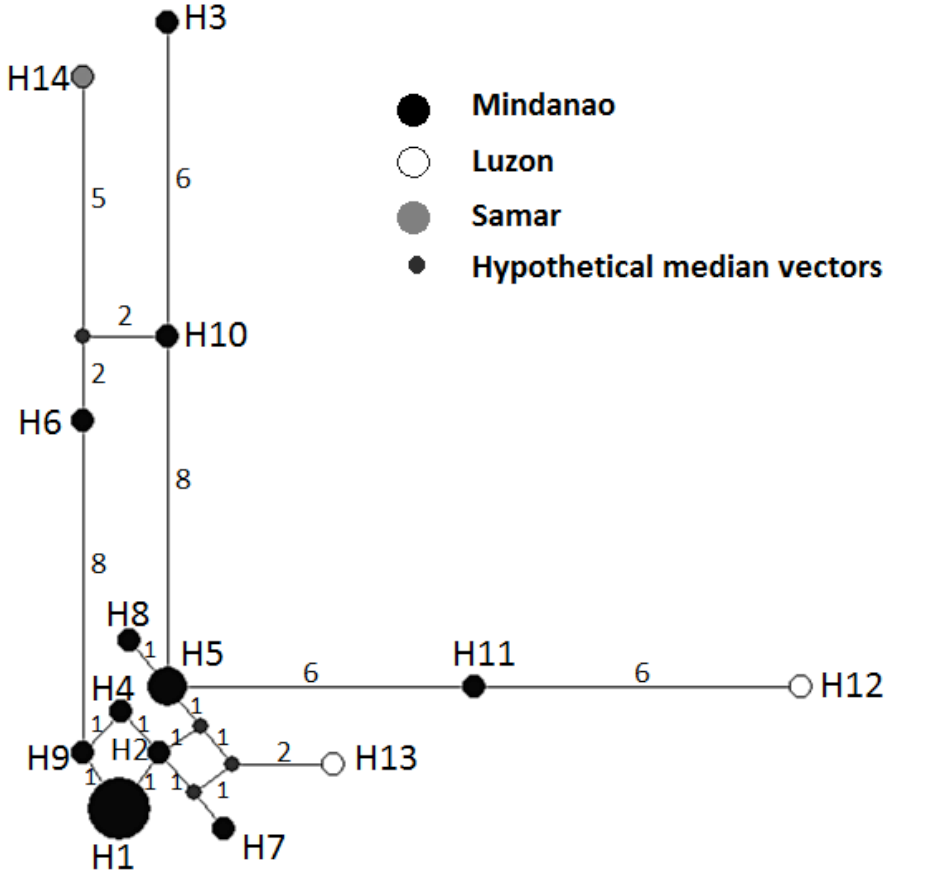
Figure 3. Median-joining network for the mitochondrial control region haplotypes of the Philippine Eagle. Circles indicate haplotypes and sizes indicate the number of individuals representing that haplotype. Black circle=Mindanao haplotypes, white circle=Luzon haplotypes, light grey circle=Samar haplotype, small dark grey circles=hypothetical median vectors. Numbers between lines denote the number of mutations between adjacent